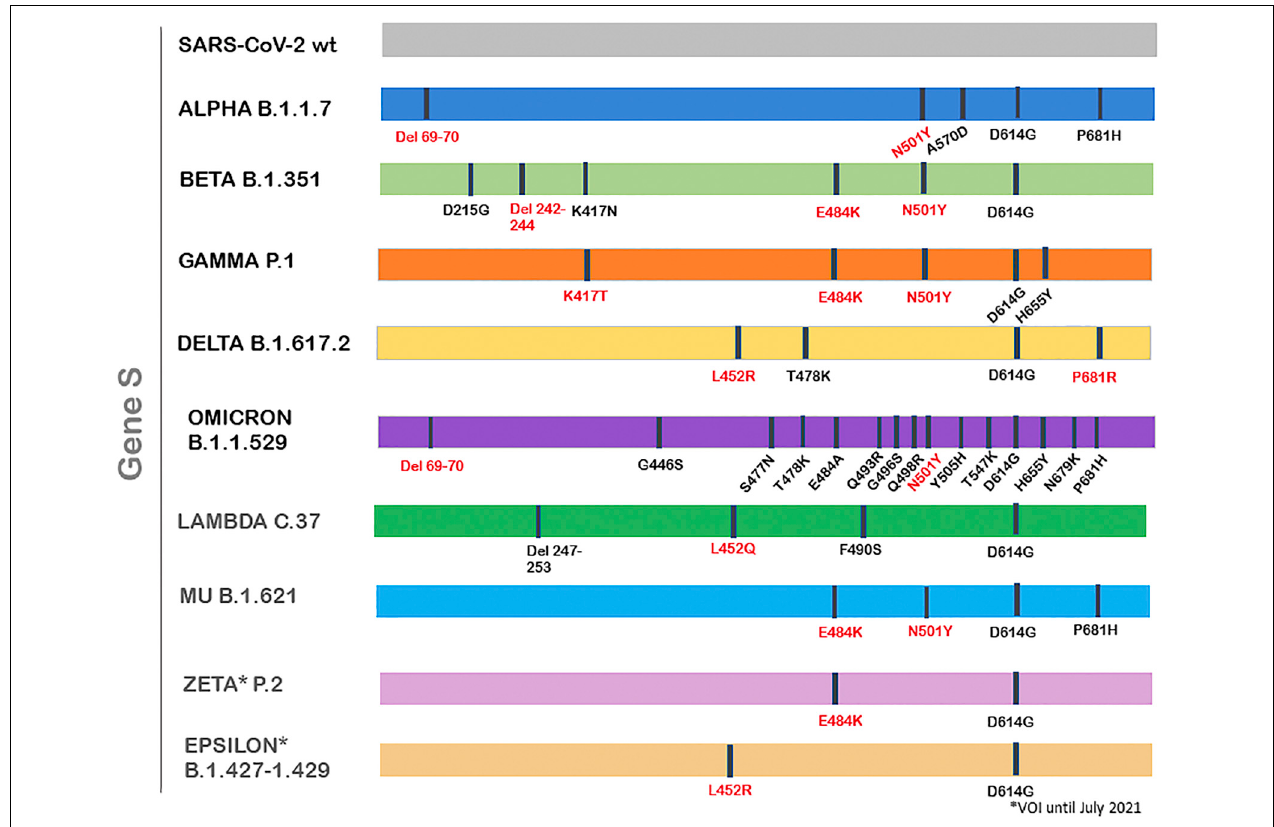
FIGURE 1 | VOC/VOIs relevant mutations within the S